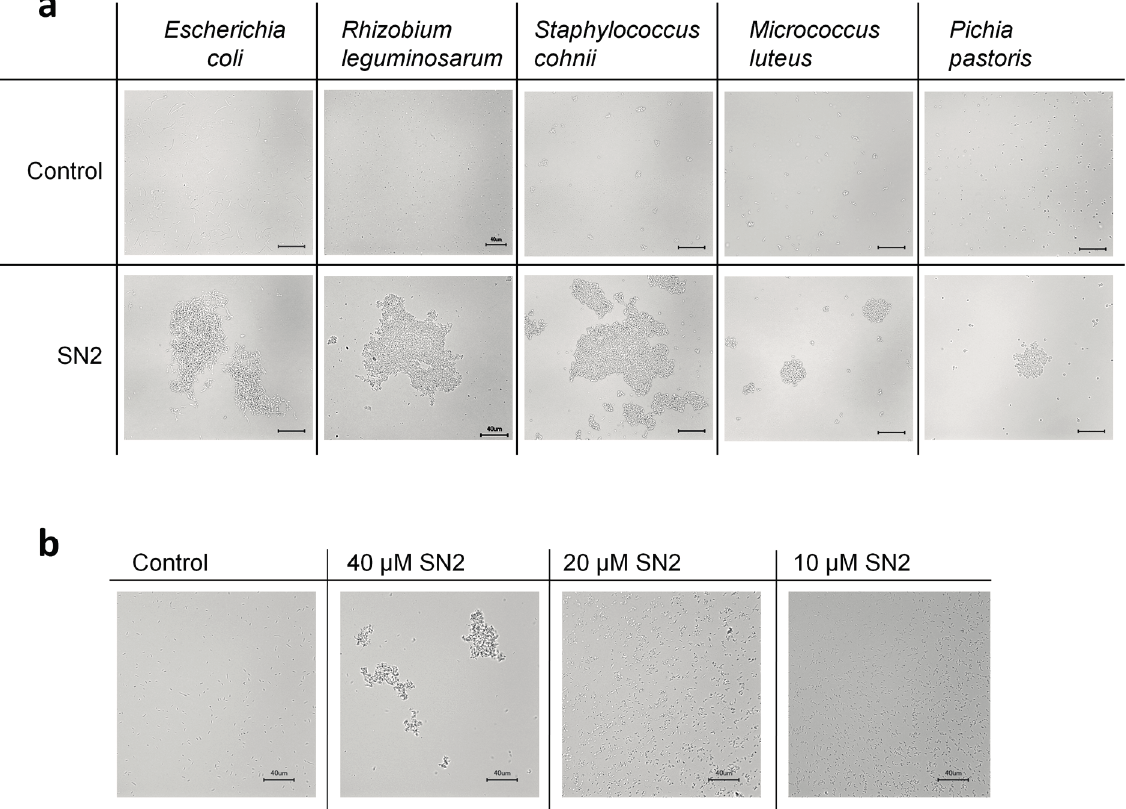
Figure 5. ( a ) Aggregation of bacteria and yeast after the addition of SN2; ( b ) dose-dependence of the agglomerating effect on E. coli caused by SN2. The scale bar represents 40